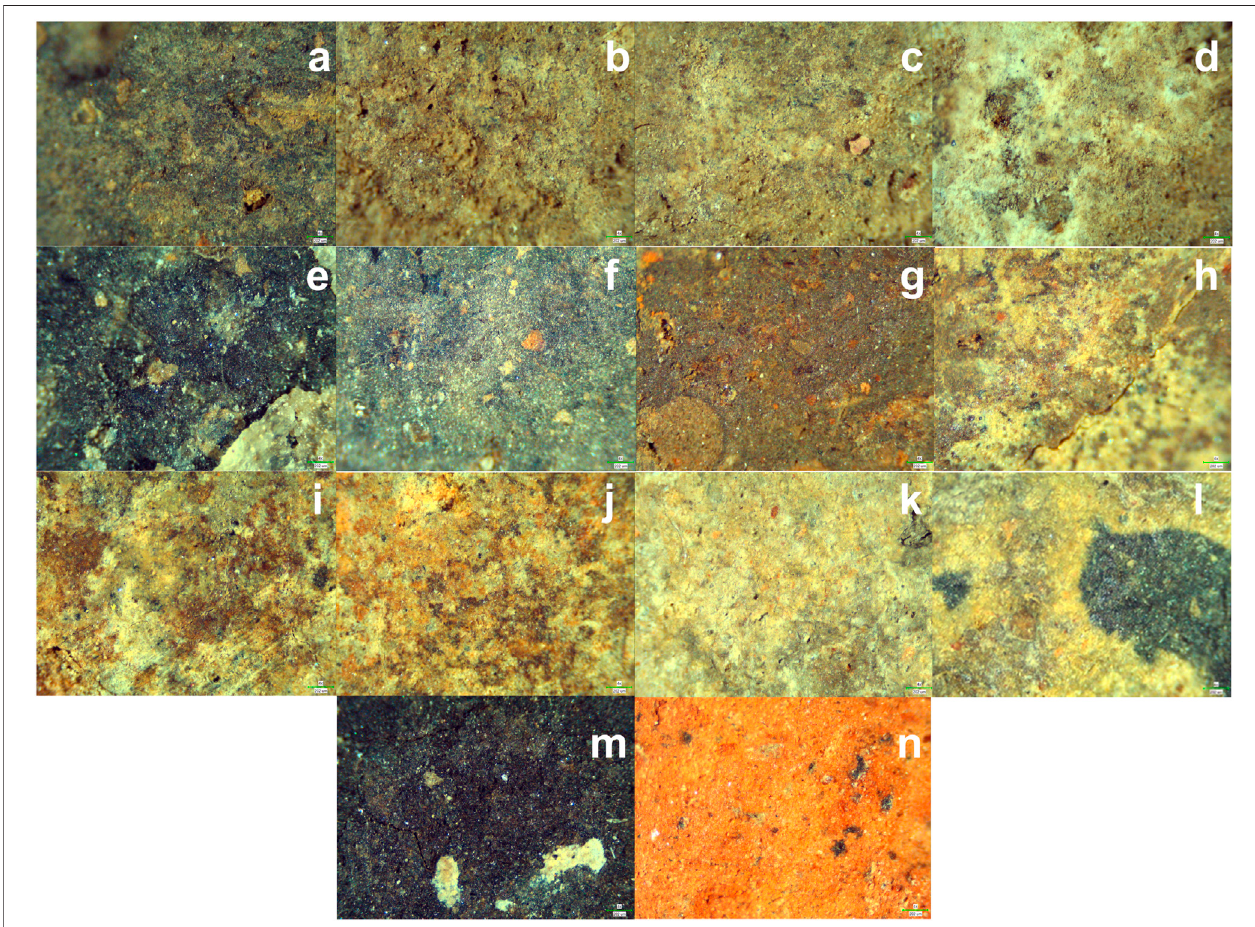
FIGURE 2 | Optical microscopy images of the analyzed samples: (A,B) – sample 1a/b; (C,D) – sample 2a/b; (E,F) – sample 3a/b; (G,H) – sample 4a/b, 4x magni fi cation; (I,J) – sample 5a/b; (K,L) – sample 6a/b; (M,N) – sample 7a/b; all images are recorded at 4x magni fi cation, scale provided on individual images.